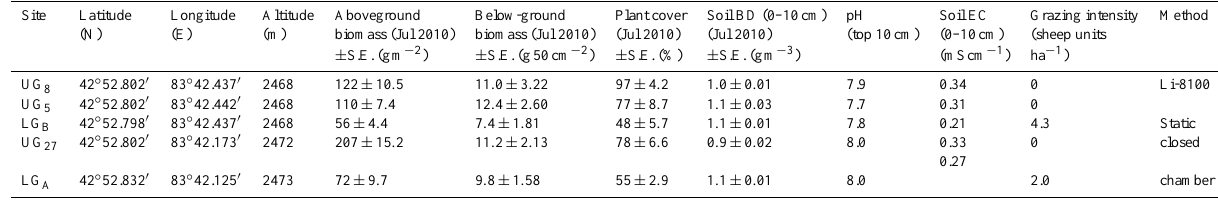
Table 1. Characteristics of the ten alpine grassland sites in the Tianshan mountains of Central Asia. Site Latitude Longitude Altitude Aboveground Below-ground Plant cover Soil BD (0–10cm) pH Soil EC Grazing intensity Method